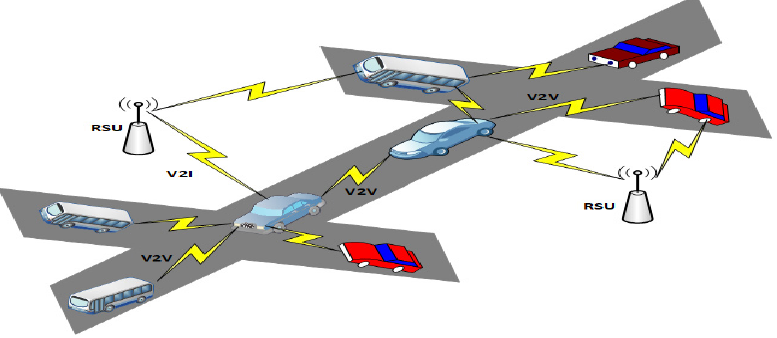
Figure 1. The general architecture of a VANET.